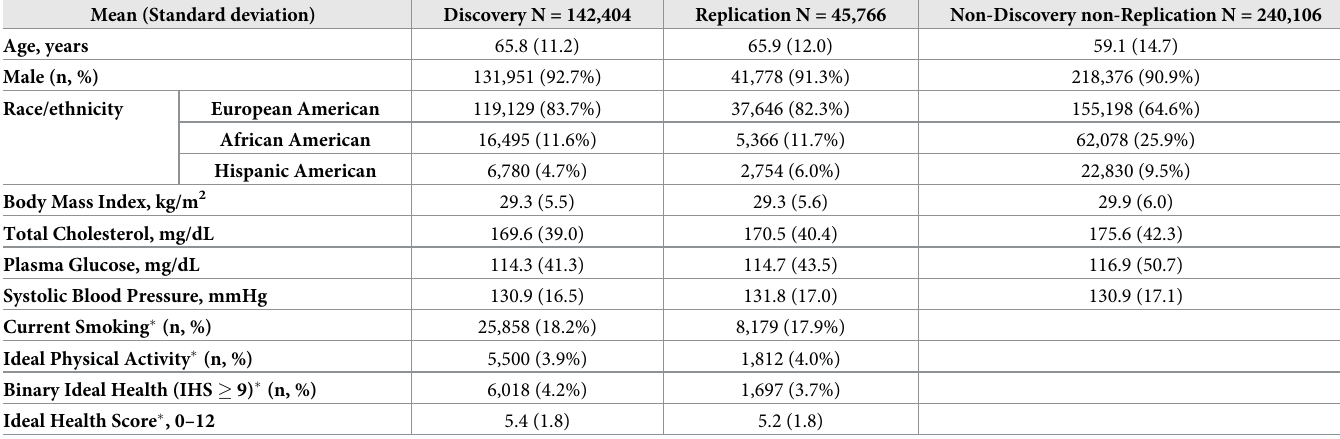
Table 1. Sample characteristics for discovery, replication, and non-discovery non-replication GWAS